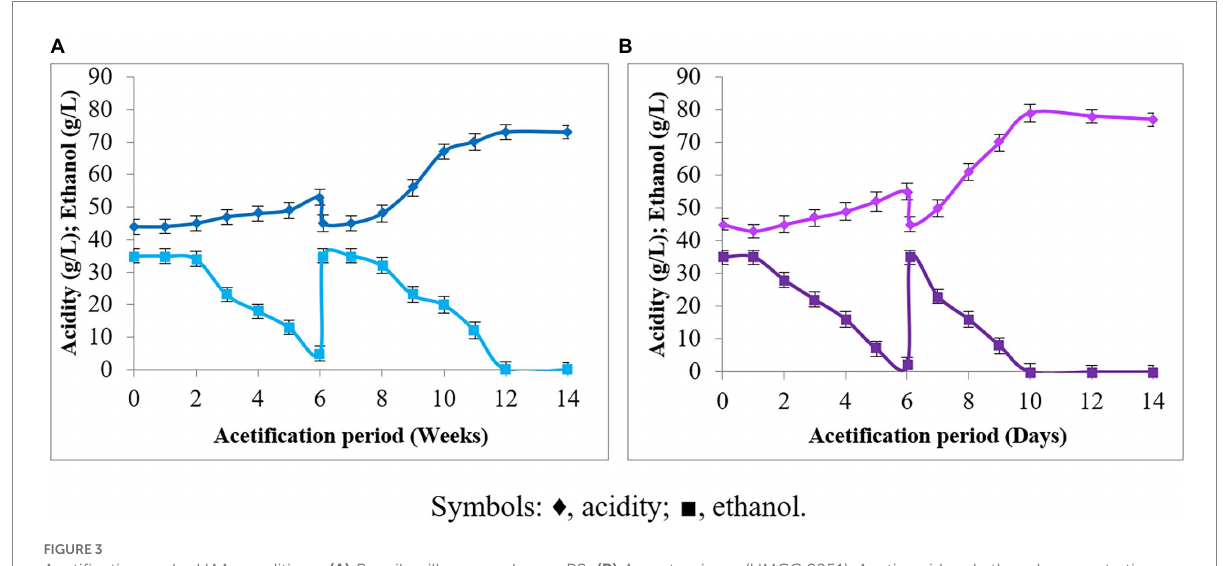
FIGURE 3 Acetification under HAA i conditions: (A) Paenibacillus azoreducens P8; (B) A. pasteurianus (UMCC 2951). Acetic acid and ethanol concentrations were adjusted constantly at 45 and 35 g/L, respectively. Symbols: ♦ , acidity (in terms of acetic acid); ■ , ethanol. Each value is the mean of three parallel replicates ± standard